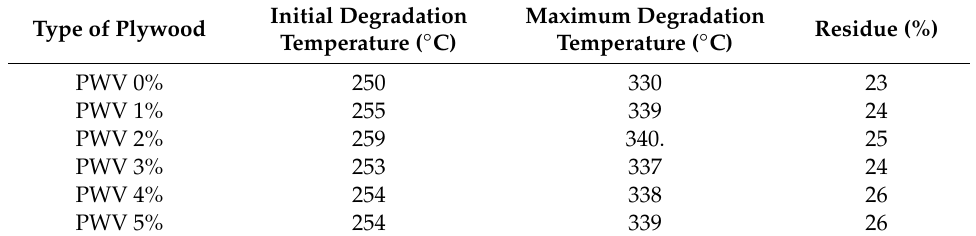
Table 3. Thermal parameters for the thermograms of PWV with di ff erent loading of PF resin-filled OPA